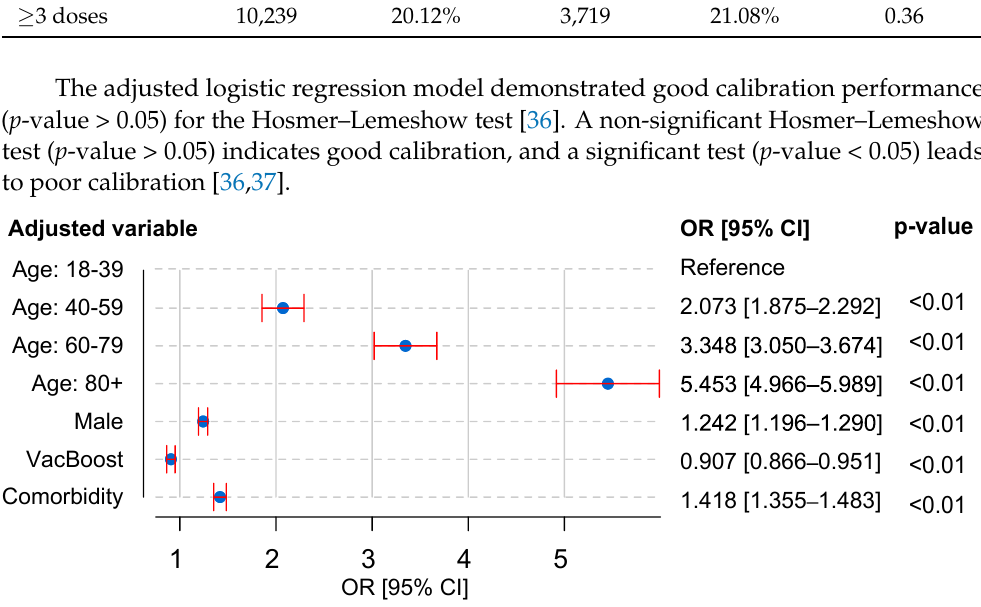
Figure 1. Adjusted odds ratio (OR) and 95% CI (red lines) for risk factors associated with COVID- 19